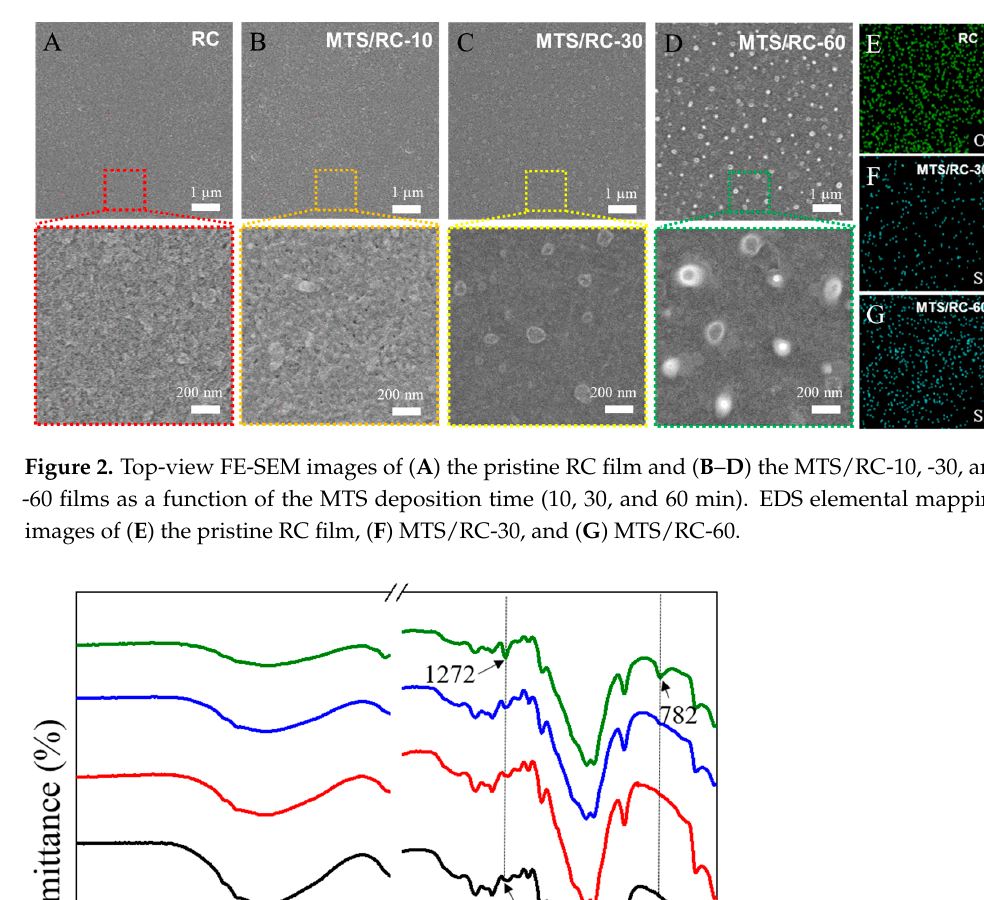
Figure 2. Top-view FE-SEM images of ( A ) the pristine RC film and ( B – D ) the MTS/RC-10, -30, and -60 films as a function of the MTS deposition time (10, 30, and 60 min). EDS elemental mapping images of ( E ) the pristine RC film, ( F ) MTS/RC-30, and ( G ) MTS/RC-60.